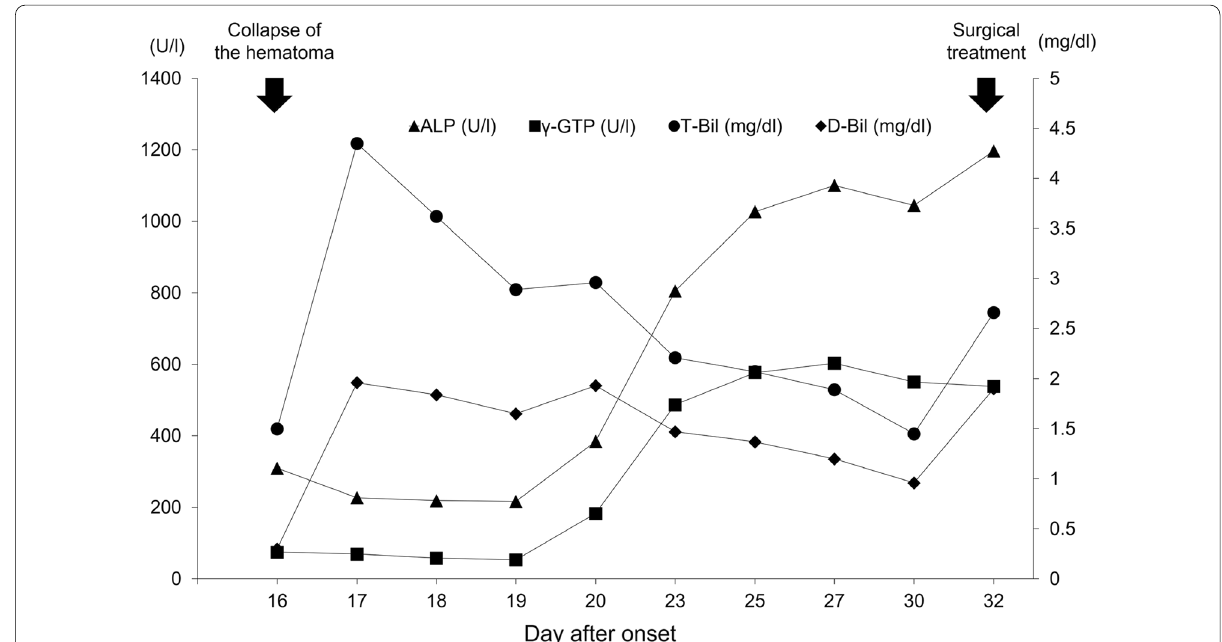
Fig. 5 Clinical course of the levels of serum bilirubin and biliary enzymes prior to the surgical treatment. ALP alkaline phosphatase, ɣ -GTP gamma-glutaryl phosphatase, T-Bil total bilirubin, D-Bil direct bilirubin